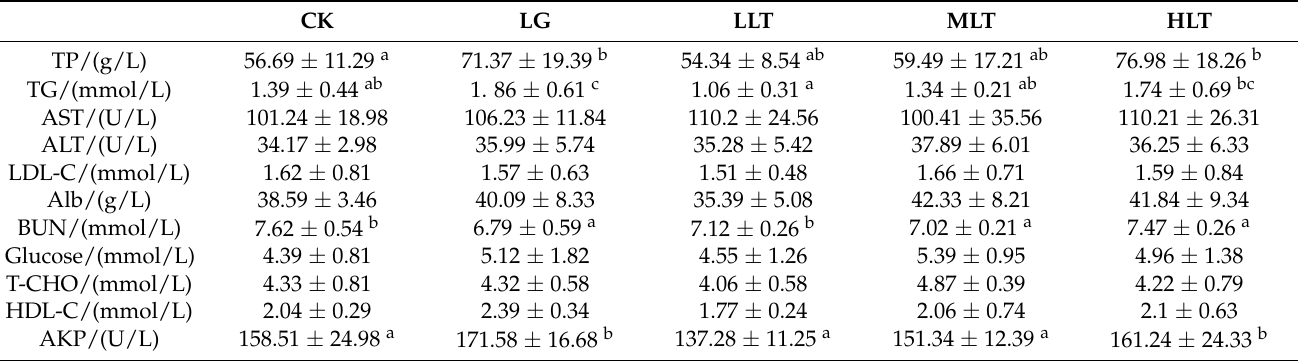
Table 1. Effects of L-theanine on serum biochemical indexes in mice. CK (control), HLT (LTA—